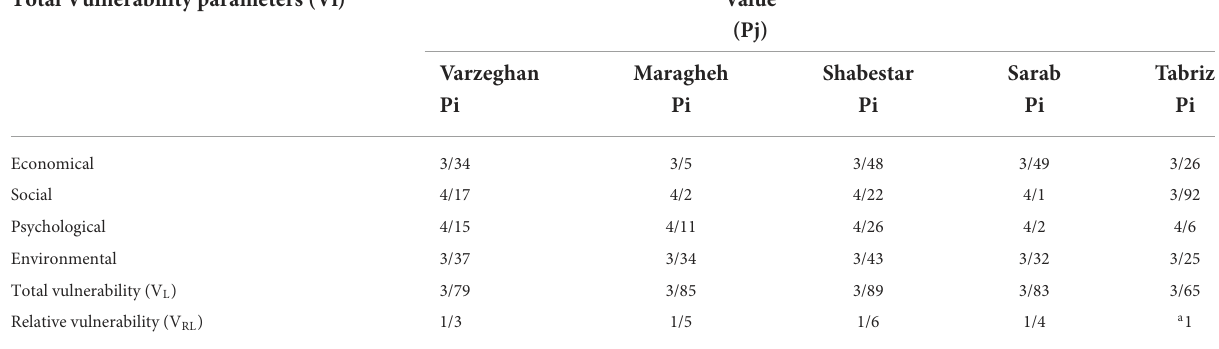
TABLE 6 Total vulnerability coefficients of the studied